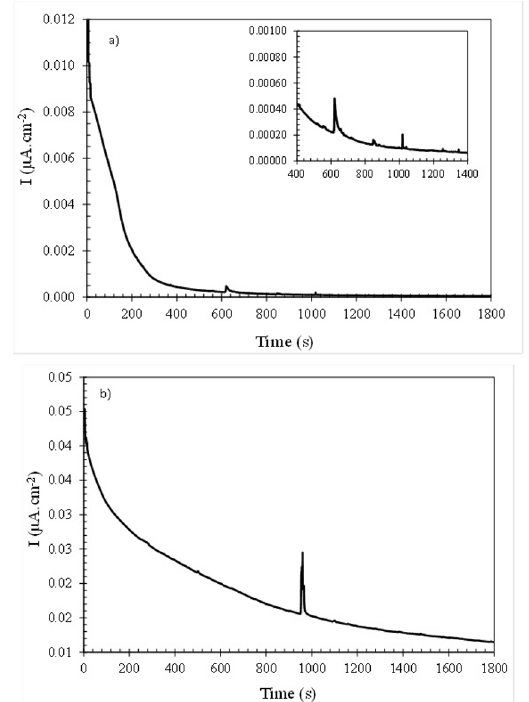
Figure 10. Current-time curves for the AISI 409 stainless steel immersed for 24 h in 0.1 M NaCl solution at room temperature at two anodic potentials: a) +100 mV mV vs. Ag/AgCl